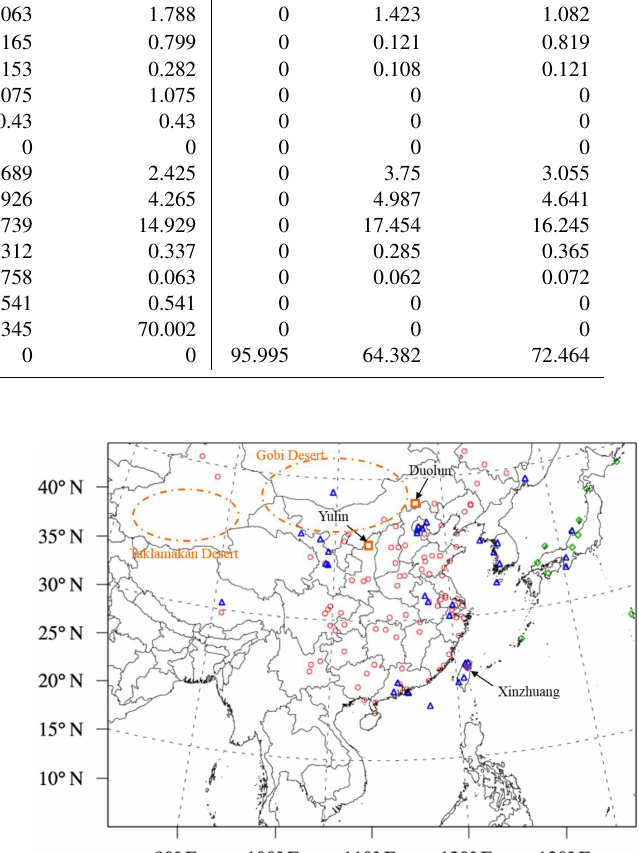
Table 4. The simulations Dust_Off and Dust_Default are de- signed to investigate the performance of the CMAQ without dust emission and with the default dust plume rise